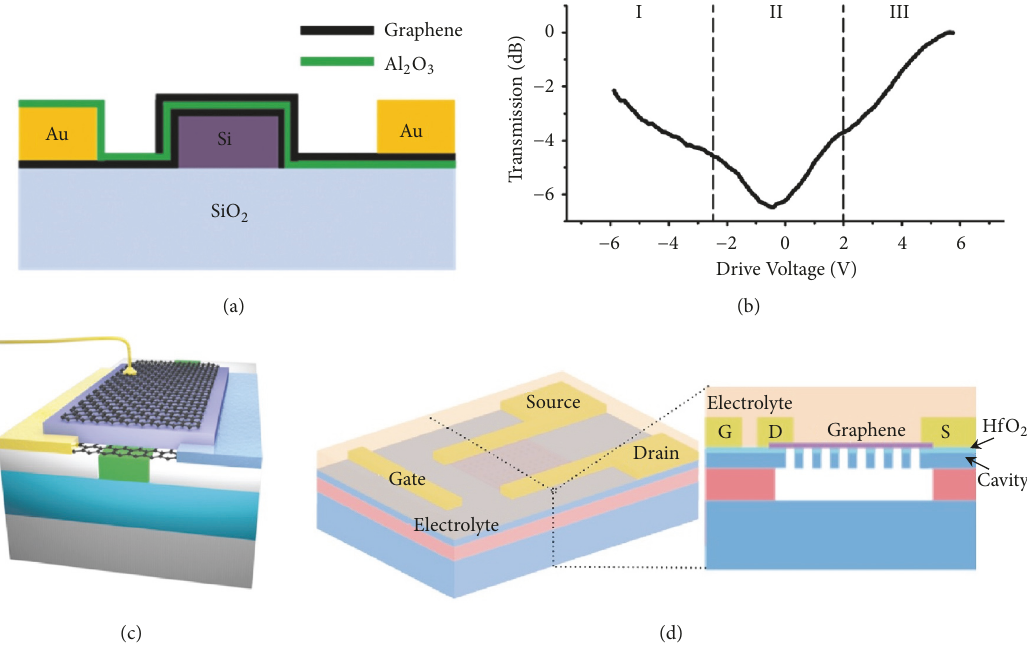
Figure 3: Schematics of waveguide-integrated graphene modulators. (a) Schematic of the dual-layer graphene modulator. (b) Graphene absorption as a function of driving voltage for the dual-layer graphene modulator. (c) Schematic of the multifunctional graphene modulator and photodetector. (d) Schematic of the graphene modulator integrated with air-suspended photonic crystal nanocavity. (a) and (b) are reprinted with permission from [35]. Copyright © 2012 American Chemical Society. (c) is reprinted with permission from [36]. Copyright © 2014 American Chemical Society. (d) is reprinted with permission from [38]. Copyright © 2013 American Chemical